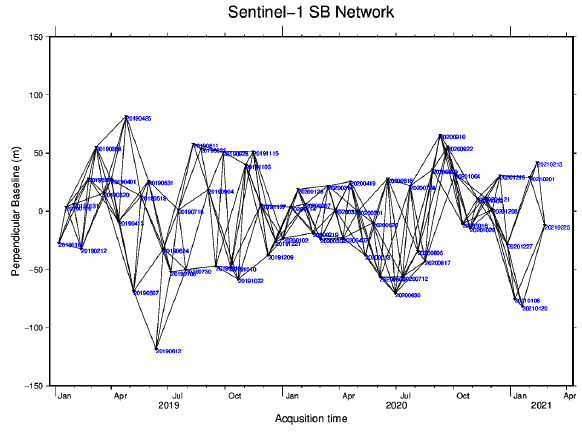
Figure 3. The small baseline network was created to process the time series InSAR technique with the PS-SDFP algorithm The InSAR processing was generally divided into two main steps. The first step was an interferometric chain in which SLC images were firstly coregistered to a super master image and continued to range and azimuth filtering (Hanssen,